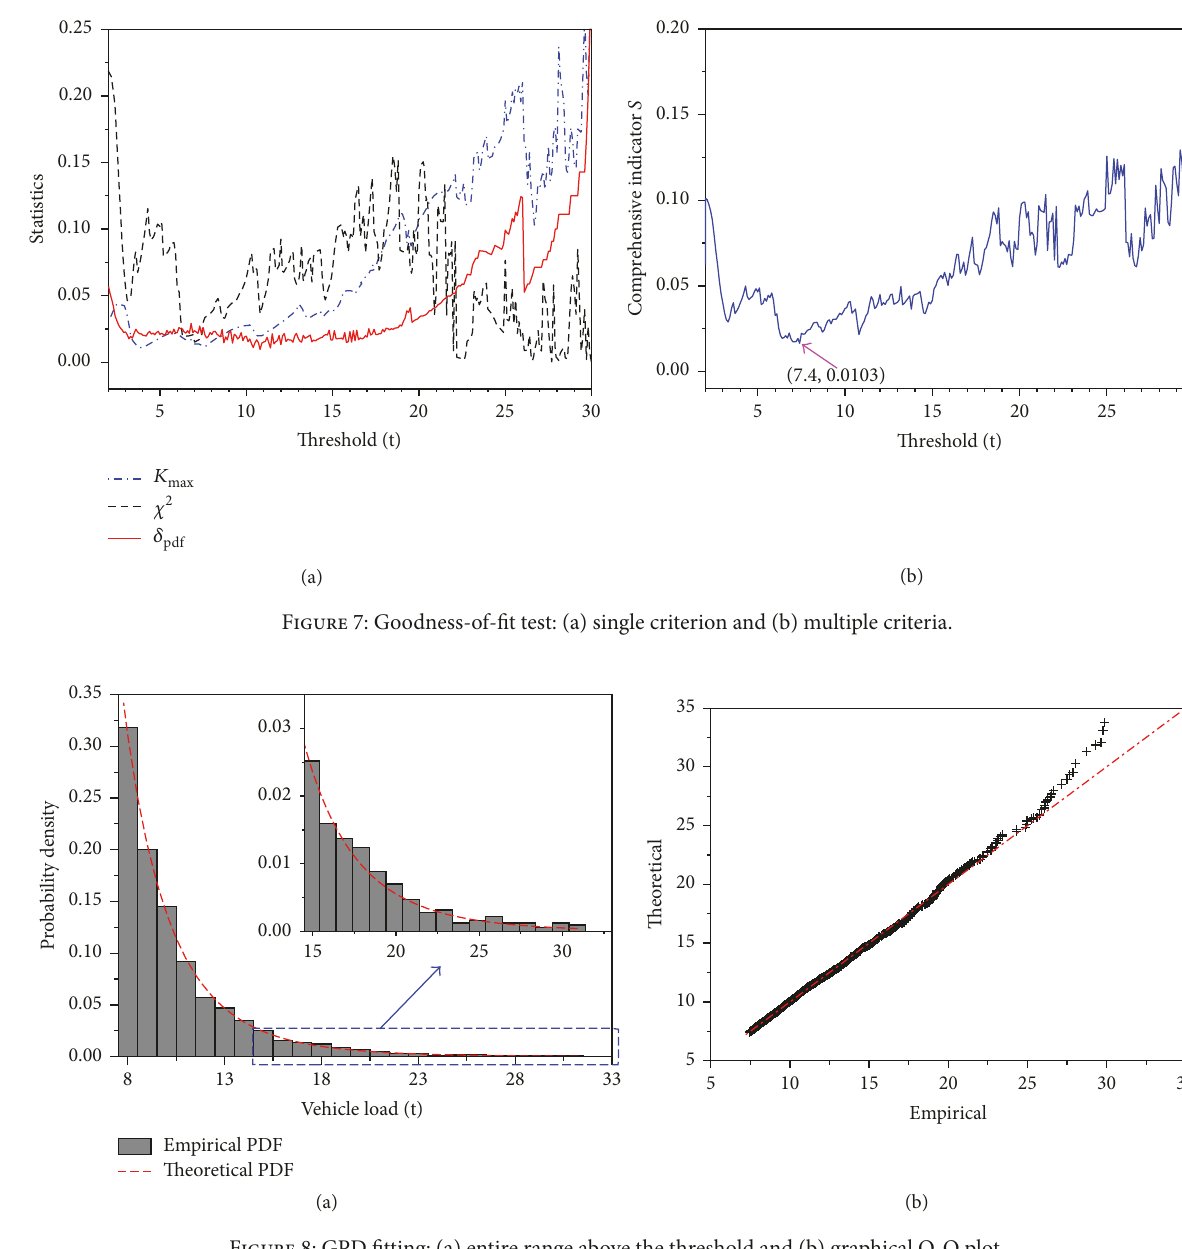
Figure 8: GPD fitting: (a) entire range above the threshold and (b) graphical Q-Q